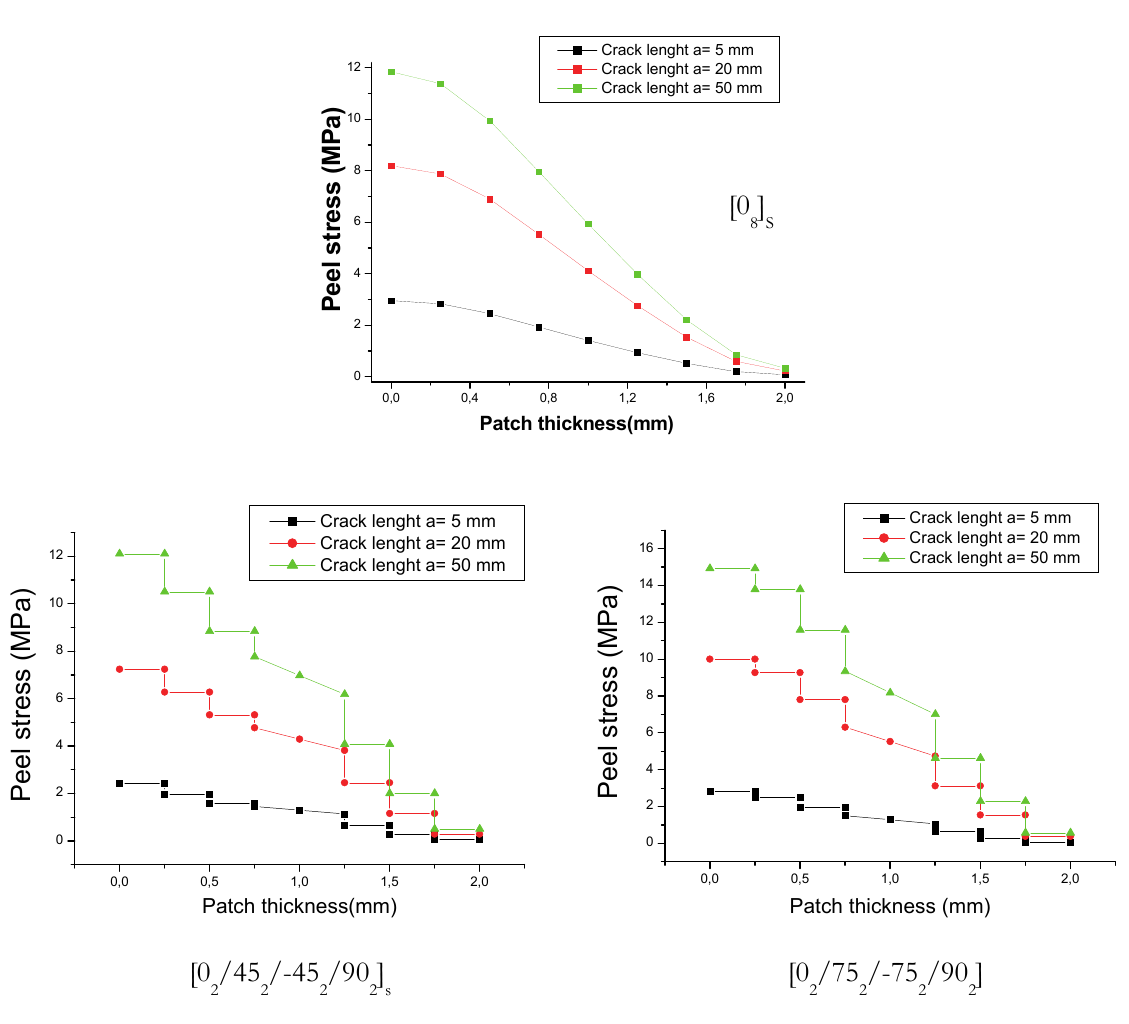
Figure 8 : Variation of the Peel Stress σ 33 as a function of the thickness of the patch for different length of crack . The value of the J-Integral increases considerably if the crack length